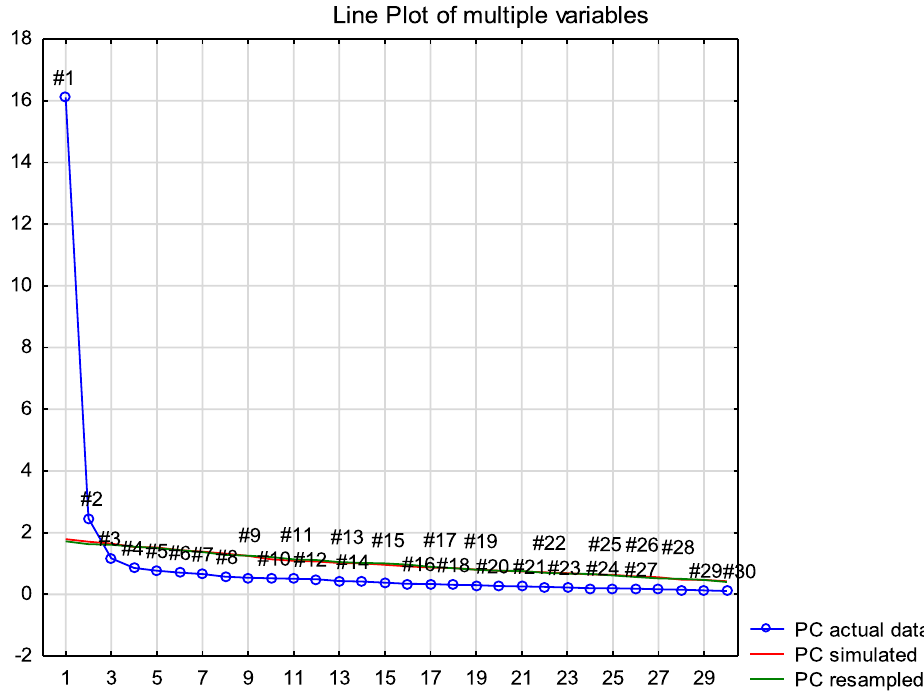
Fig. 1 Scree plot parallel analysis (Afrikaans for the Western